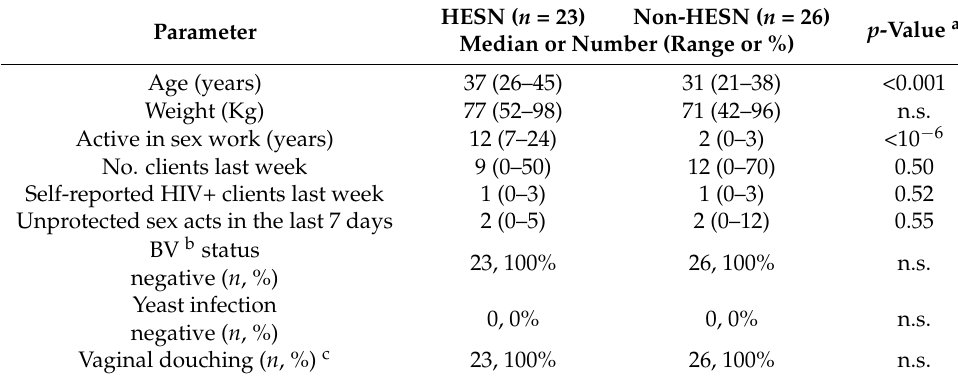
Table 1. Clinical characterization of study subjects at